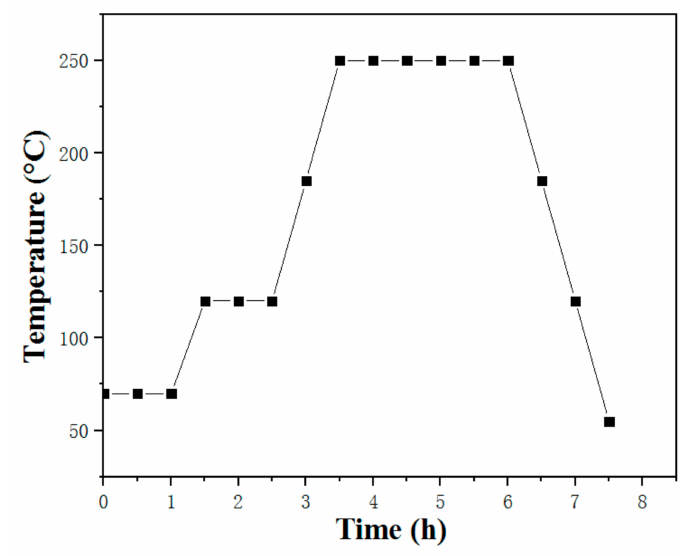
Figure 4. The stepped heating process for curing the composite or PI precursor.